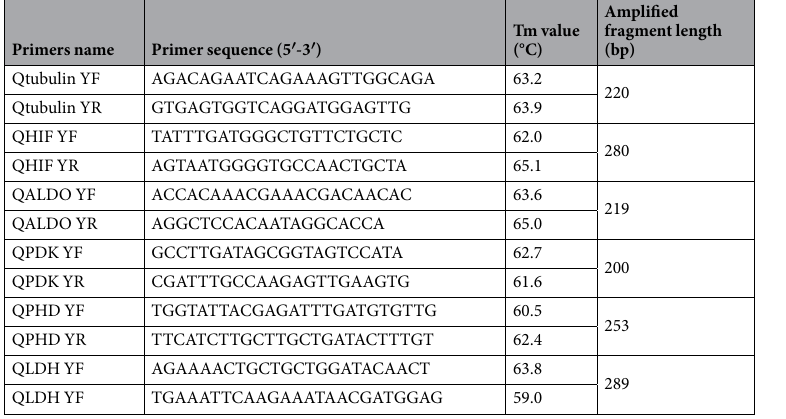
Table 1. List of quantitative primers